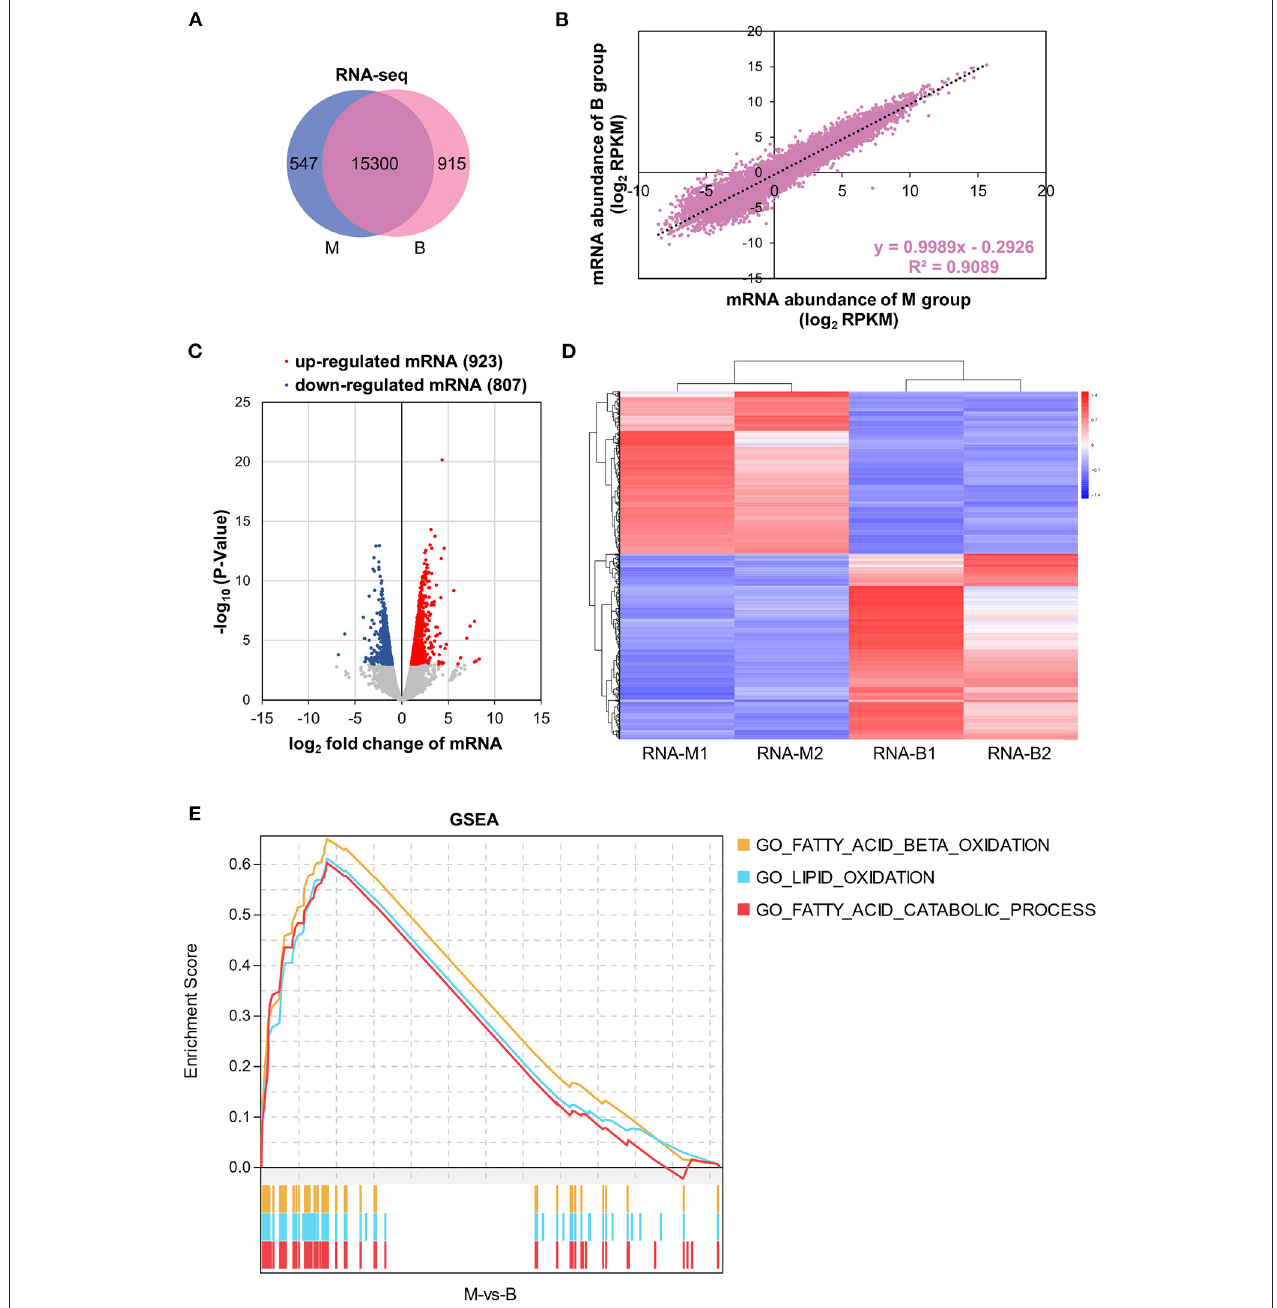
FIGURE 3 | Transcriptome analysis. (A) Venn diagram showing the distinct and overlapping genes of the transcriptome. (B) Correlation of mRNA abundance. (C) Volcano plots of liver DEGs of the transcriptome. (D) Heatmap with hierarchical clustering analysis of DEGs of the transcriptome. The color scale indicates the mRNA expression levels; blue is the lowest and red is the highest. (E) GSEA of the transcriptome. A pathway of positive Enrichment Score is up-regulated, whereas a pathway of negative Enrichment Score is down-regulated. M1 and M2 represent group M biological repetition 1 and 2. B1 and B2 represent group B biological repetition 1 and